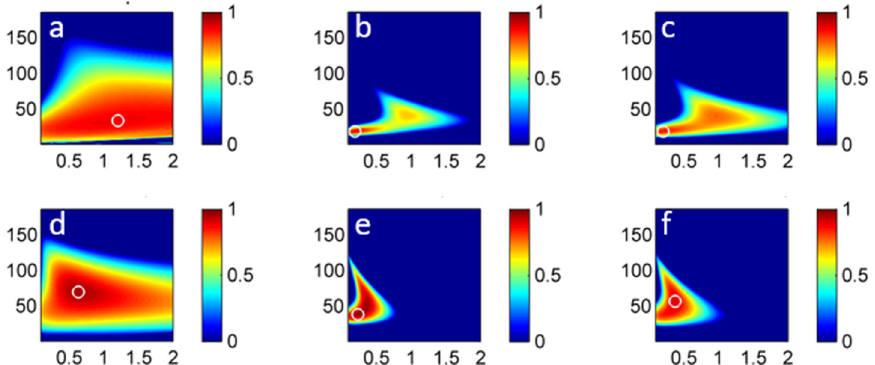
Figure 13. Map of optimal parameters resulting from the analysis on an annual scale ( a ) for the backfill, ( d ) for the Barthelasse; then on a flood scale ( b ) for the backfill, ( e ) for the Barthelasse and finally taking into account the two temporal scales ( c ) for the backfill and ( f ) for the Barthelasse. The high-frequency monitoring considerably reduces the variability of the two param- eters. The optimised Dp parameter is this time comparable for the two sites with a value of 0.15 and 0.25 for the backfill and Barthelasse,